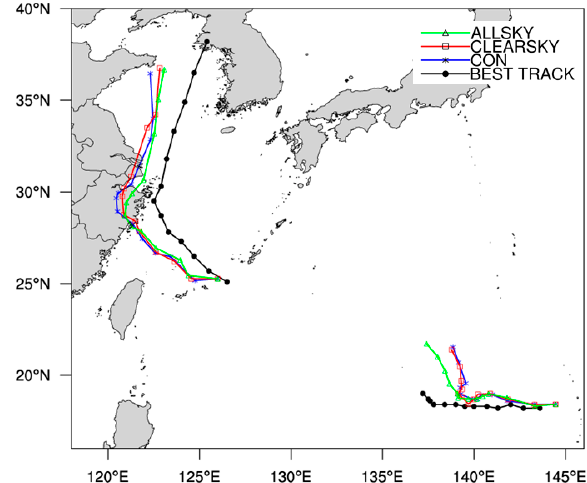
Figure 8. The best-track data (black) and 72-h forecast track (every 6 h) from CON (blue), CLEARSKY (red), and ALLSKY (green) experiments for Chan-hom (upper left) and Nangka (lower right), starting from 1800 UTC 9 July.